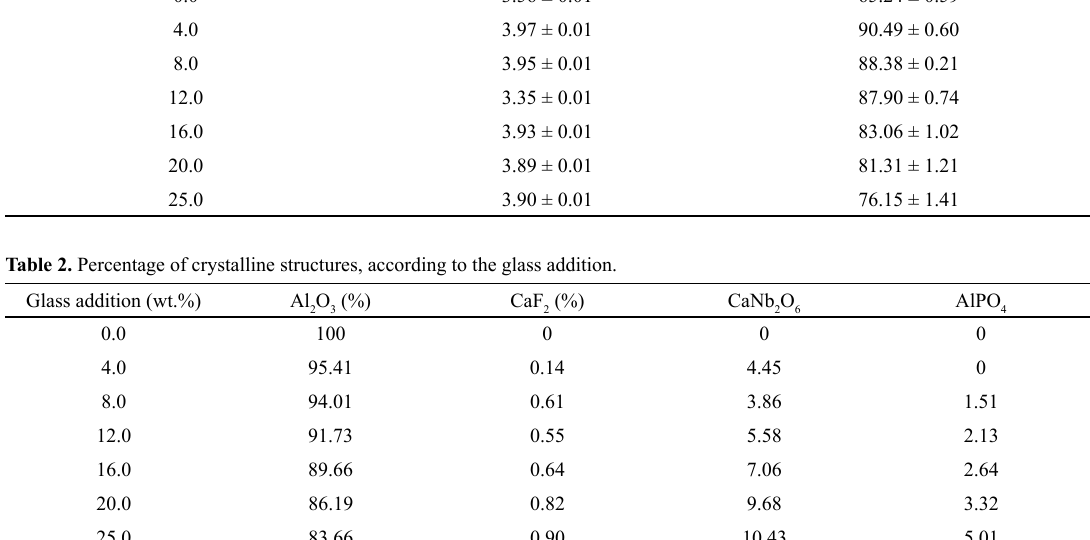
Table 1. Values of density and densification of the sintered samples. Glass addition (wt.%)